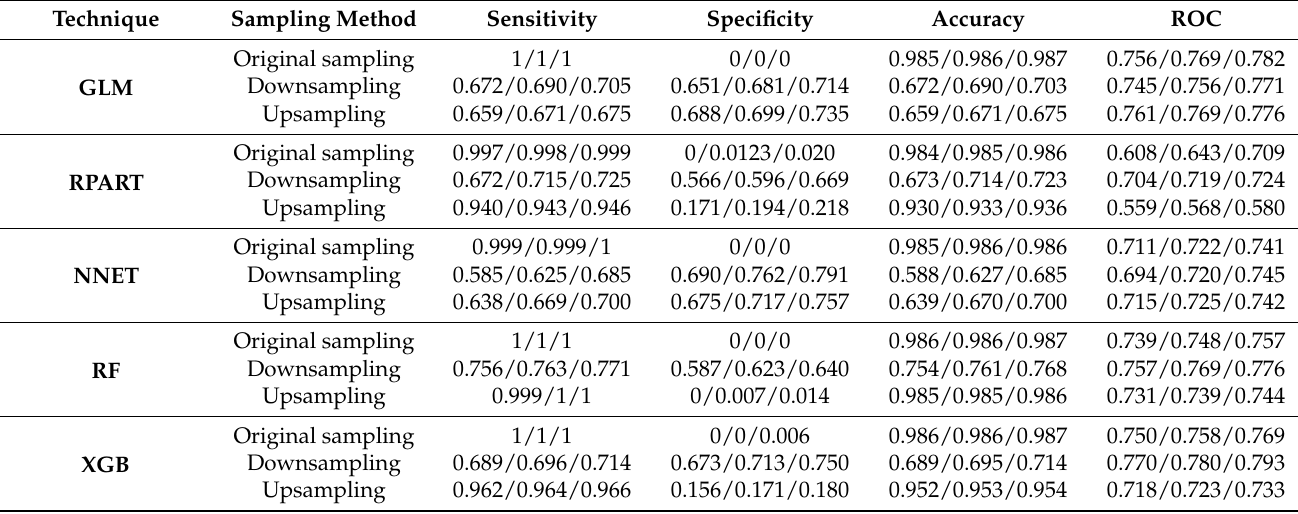
Table 2. Comparison of the performance of the MLT algorithms (after missing data imputation). Measures are reported as I quartile/median/III quartile.